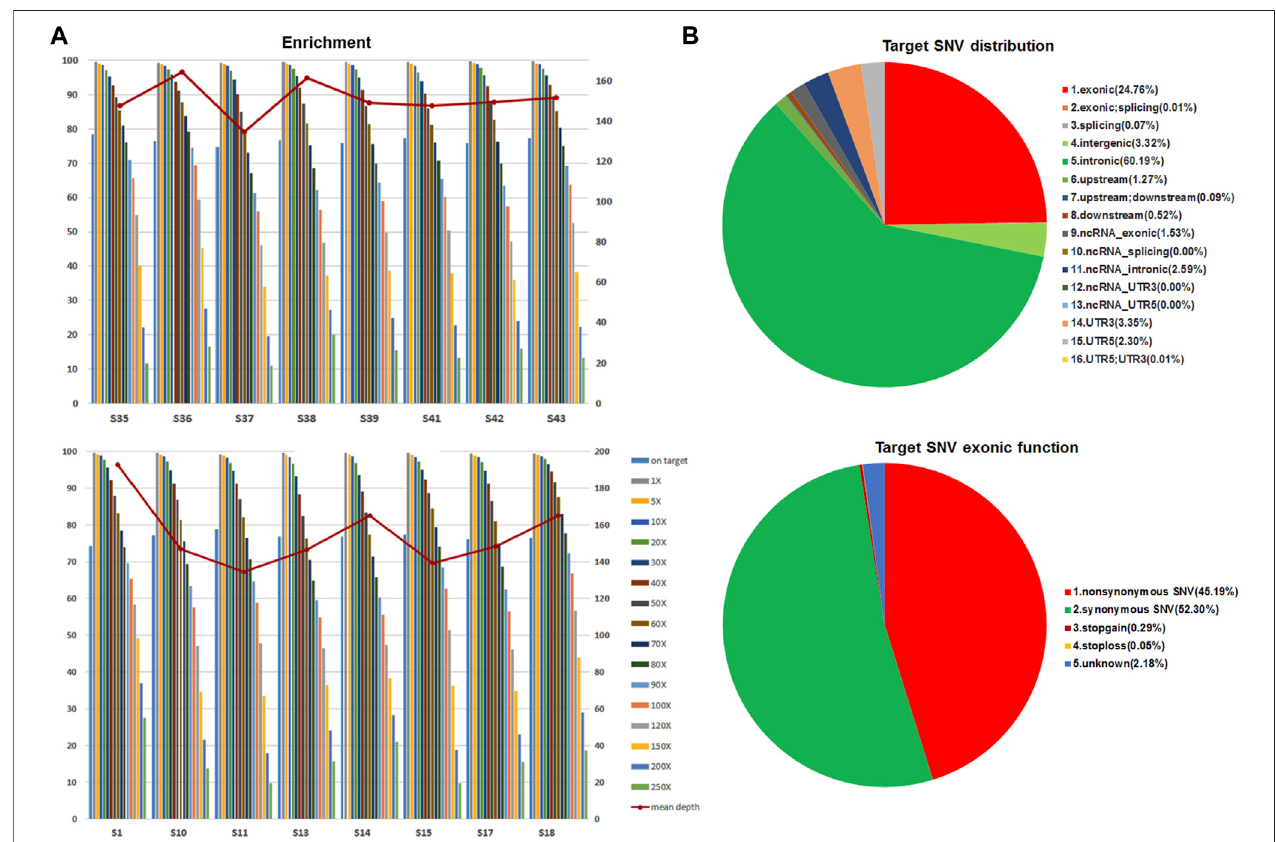
FIGURE1| MeanenrichmentanddepthofWESonFFPEGISTtissuesandSNPdistribution.( A )RepresentativeresultsofuniquemappedratiosandlengthofWES assay on 49 FFPE GIST tissues. ( B ) The mean target SNV distribution in 49 GIST tumors.